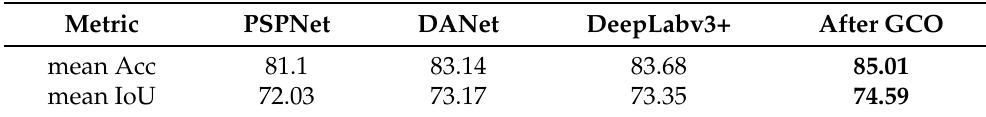
Table 2. Overview of fine-grained semantic segmentation results of PSPNet [43], DANet [44], DeepLabv3+ [34] and our GCO optimization based on DeepLabv3+ on Dataset